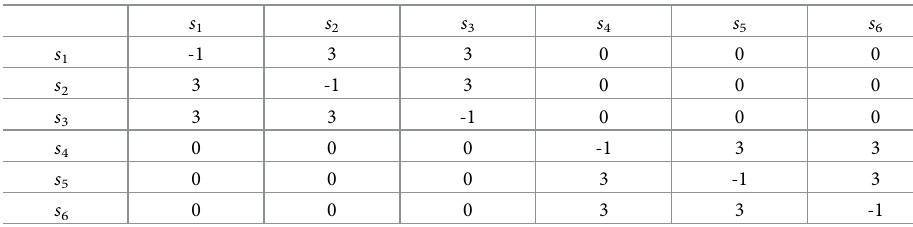
Table 6. Matrix A for posets in Fig 13.